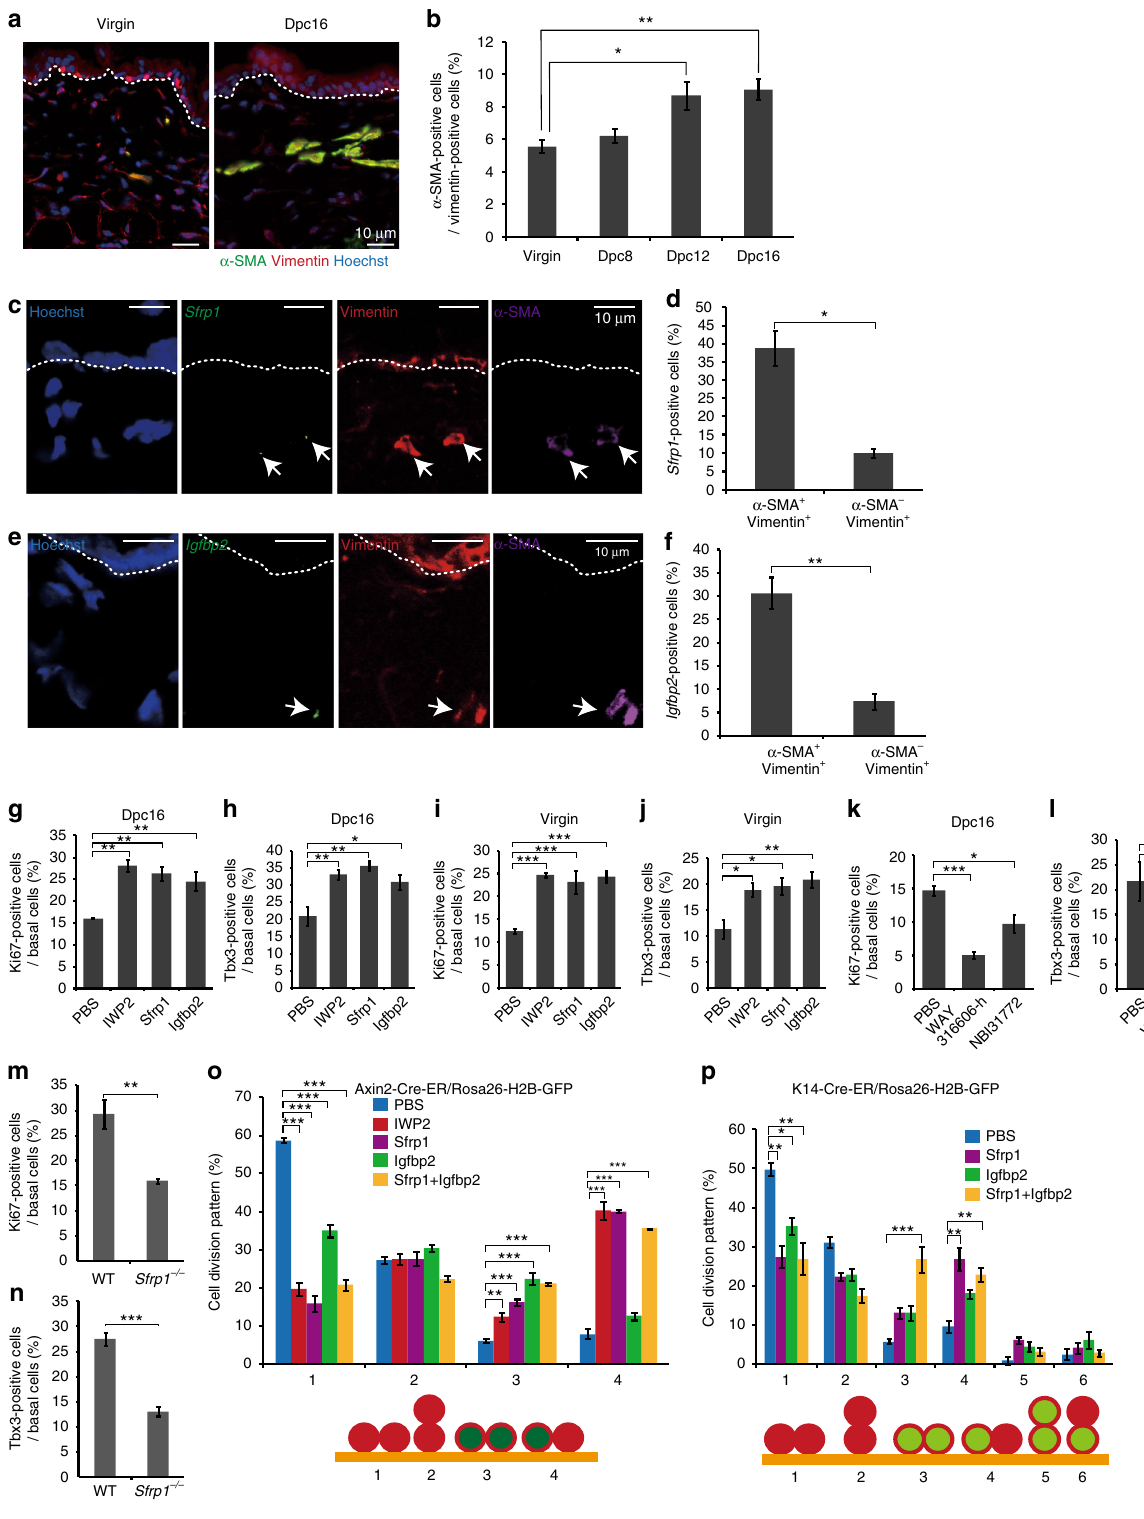
dynamicity of the Axin2 + and Tbx3 + IFE basal cells in the abdominal skin of pregnant mice. Increasing evidence has sug- gested cross-talk between dermal and epidermal cells in normal and malignant skin tissues 28, 29 . Therefore, we hypothesised that secretory proteins derived from dermal cells are the source of the signals for Axin2 + and Tbx3 + IFE basal cells in the abdominal skin of pregnant mice. In support of this hypothesis, a